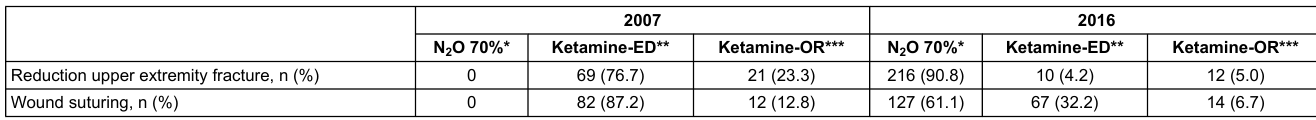
Table 3: Procedural analgosedation for reduction of upper extremity fractures and wound suturing in 2007 and